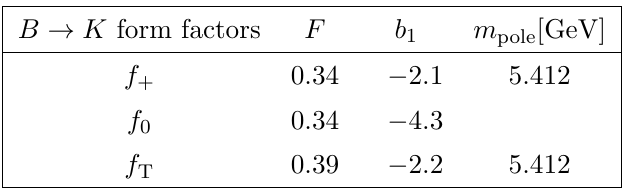
Table 4 . Results for (cid:1) R M , the relative QED radiative correction of R K (cid:3) for B ! K (cid:3) ‘ + ‘ (cid:0) induced K (cid:3) by the magnetic-dipole corrections as de(cid:12)ned in the text, for a representative set of integrated q 2 bins in the range q 2 < q 2 < q 2 . max min